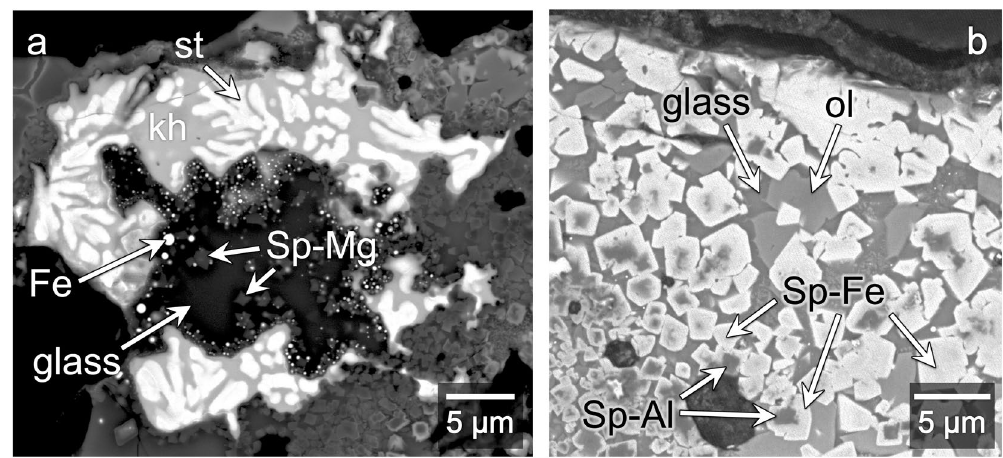
Figure 6. BSE images of various spinel phases. Compositions for spinel phases shown here are provided in Table 2c. ( a ) Close up of region overlapping with Locations 11 (Fig. 2a) and 18 (Fig. 2b). Khatyrkite (“kh”) and stolperite (“st”) have a texture indicating crystallization from a melt. Metallic Fe beads (“Fe”) line the interior interface. Spinel crystals that grew here in the silicate melt (now glass) are denoted as “Sp-Mg”. They have lower concentrations of FeO and Fe 2 O 3 than the spinel crystals shown in ( b ). ( b ) Close up of Location 20 (Fig. 2b) showing Fe-rich spinel crystals (“Sp-Fe”) and zoned spinel crystals with Fe-rich rims (also marked “Sp-Fe”) and Al-rich cores (“Sp-Al”), all surrounded by glass. In contrast to ( a ), this region does not have Fe beads, but the spinel crystals here have higher concentrations of FeO and Fe 2 O 3 than those in ( a ). Also noted in the image are olivine crystals (“ol”, Fo 50 -Fo 56